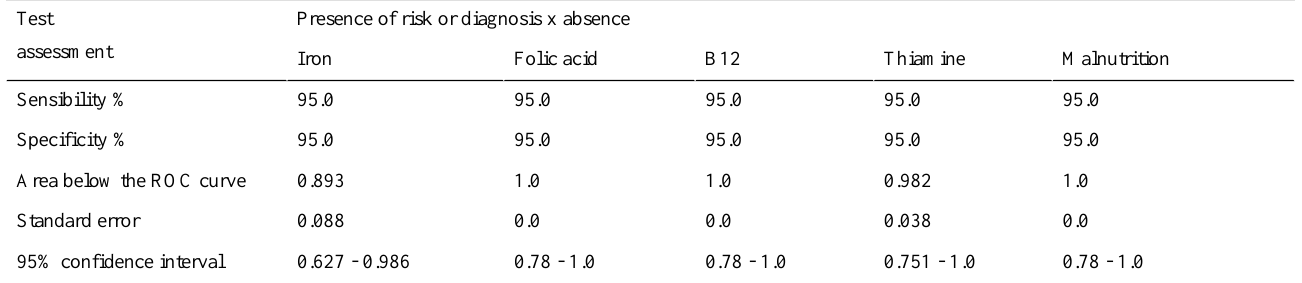
Table 2. BN diagnosis test